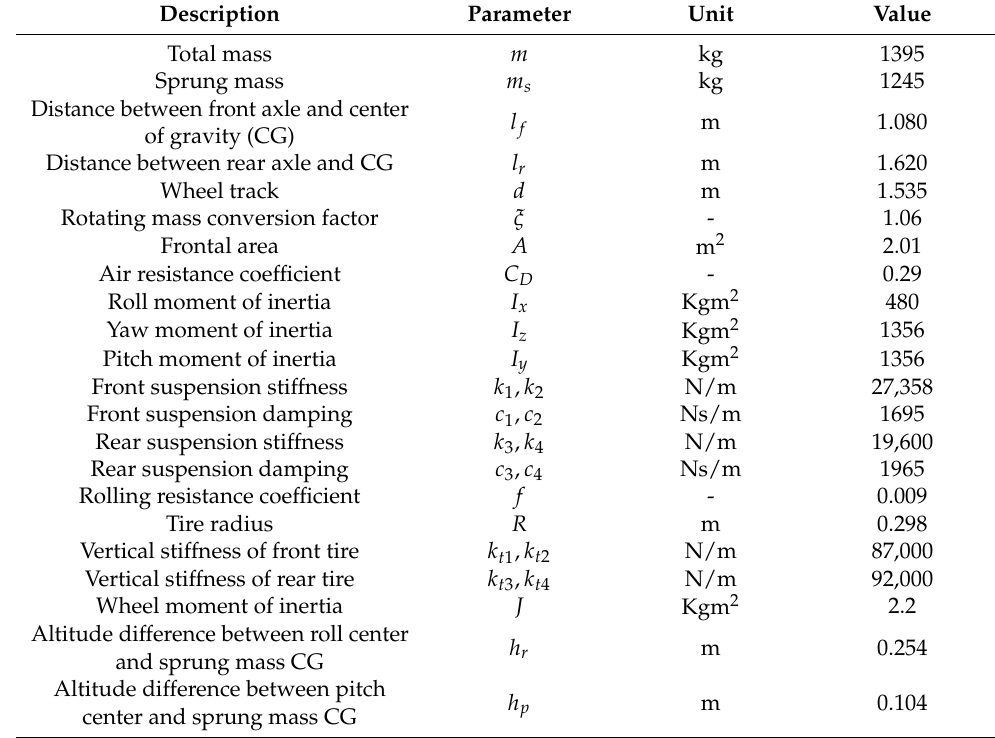
Table 1. Vehicle parameters in this paper.